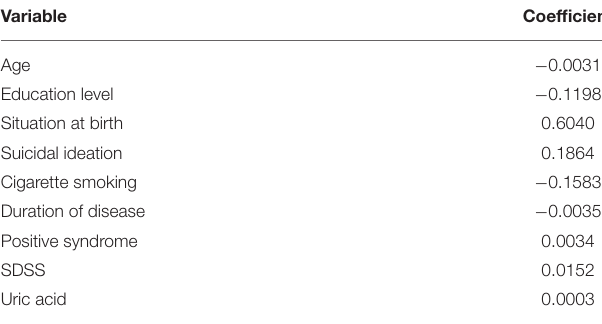
TABLE 2 | The variables selected by